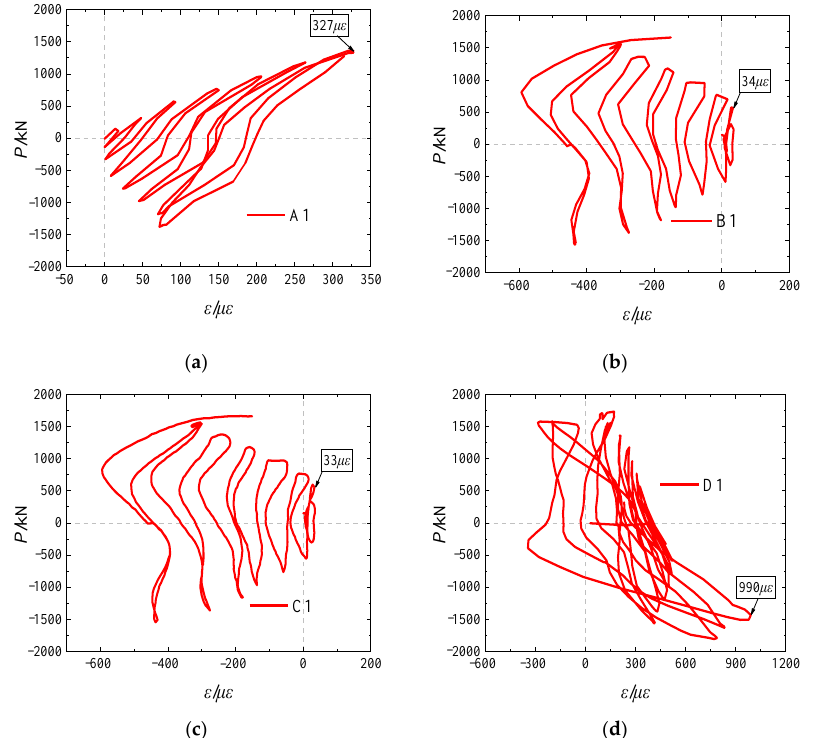
Figure 14. Load–strain curves of the steel plates at the top and bottom of the RCFSTKs. ( a ) Steel plate strain at RCFSTK A1; ( b ) Steel plate strain at RCFSTK B1; ( c ) Steel plate strain at RCFSTK C1; ( d ) Steel plate strain at RCFSTK D1.